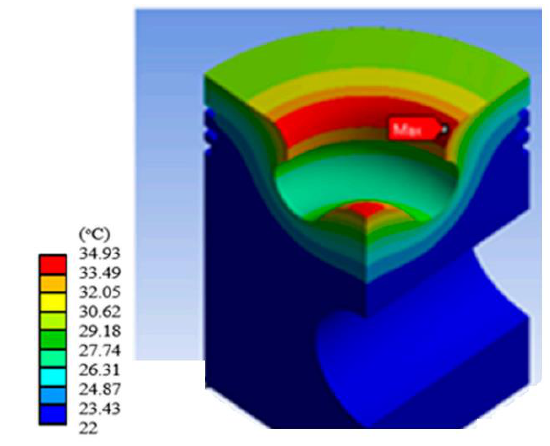
Fig. 1. Numerical analysis of the temperature gradient of a piston in a diesel engine [10]